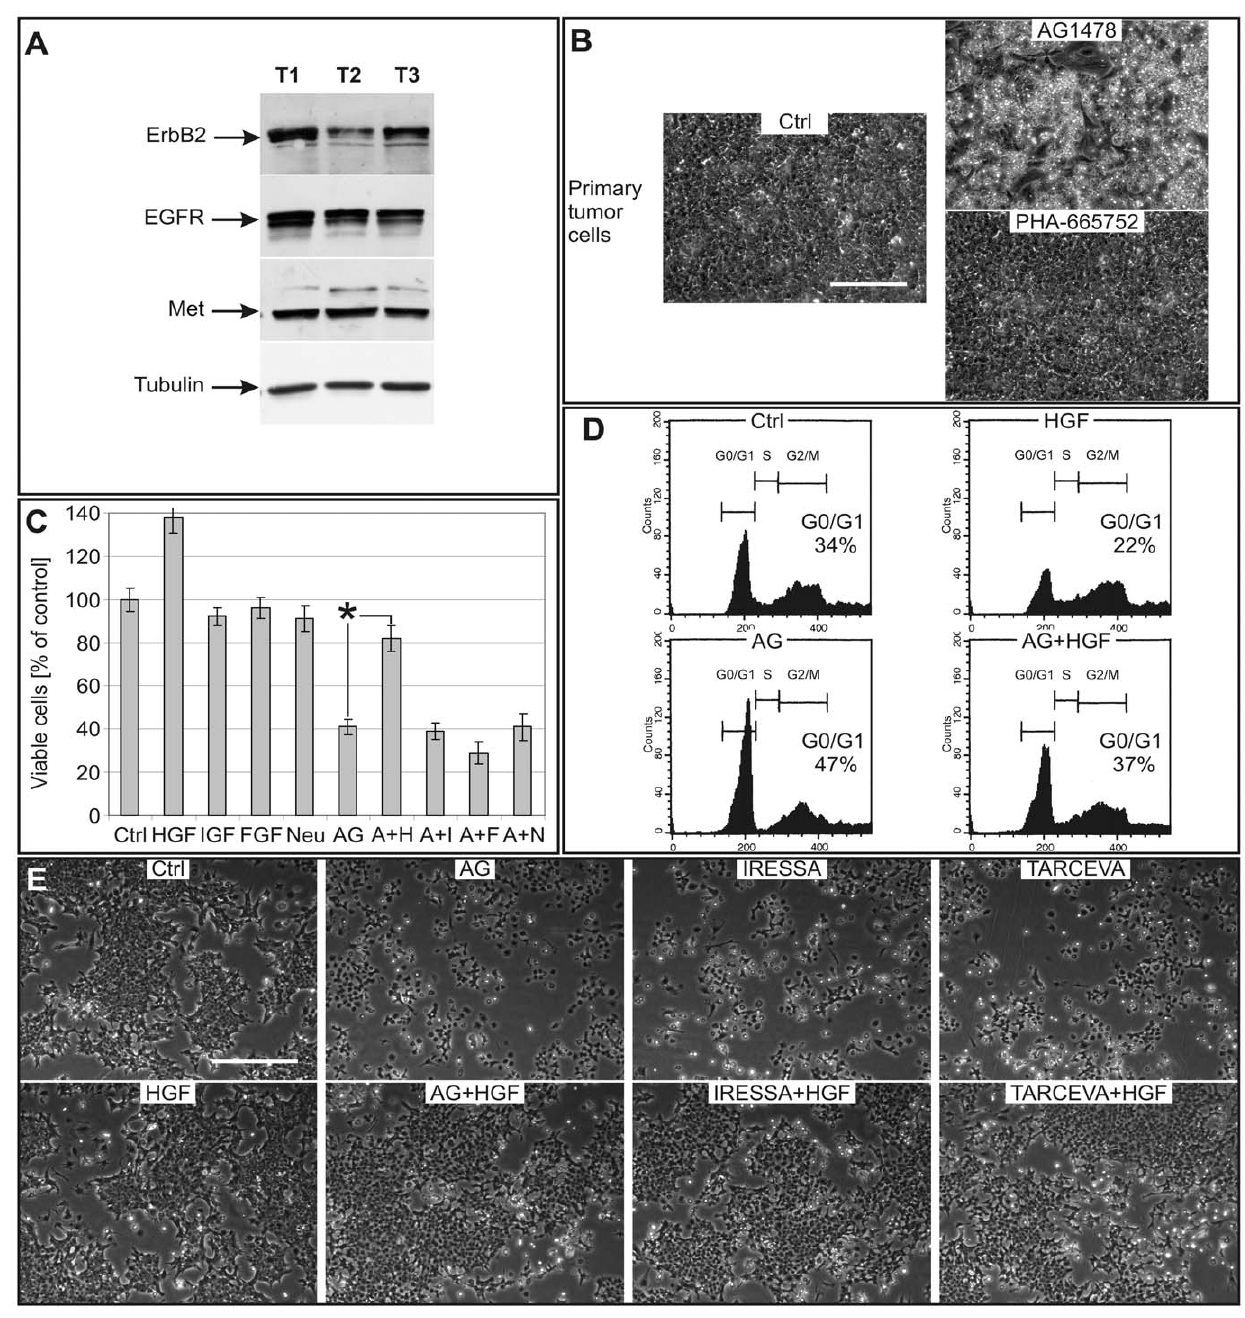
Figure 4. HGF is a survival factor of EGFR inhibited ErbB2 mammary tumor cells. A. Western-blot analysis of ErbB2, EGFR and Met expression in mammary tumors obtained from three separate transgenic ErbB2 mutated mice (see materials and methods). Tubulin was used as an internal loading control. B. Phase contrast images of primary cells from ErbB2 mammary tumors (bar =500 m m). Cells were grown in proliferation medium and either left untreated (Ctrl) or treated with AG1478 (250 nM) or PHA-665752 (250 nM) for 96 h. C. Viable cell count by trypan-blue exclusion staining at 48 h, of immortalized ErbB2 tumor cells treated with the indicated factors (HGF 10 ng/ml (H), IGF-I 100 ng/ml (I), b-FGF 20 ng/ml (F), Neuregulin 20 ng/ml (N); AG1478 250 nM (A)). Untreated control (Ctrl) was set to 100%. Columns, mean (n=6); bars, S.E.M. *P , 0.05. D. Cell cycle distribution examined by propidium iodide staining and FACS analysis of ErbB2 mammary tumor cells cultivated in growth medium and treated with the indicated factors for 16 h (HGF 10 ng/ml, AG1478 250 nM). E. Immortalized ErbB2 tumor cells cultivated in their respective growth medium for 48 h with the indicated factors (HGF 10 ng/ml; AG1478 250 nM; IRESSA 1 m M; TARCEVA 1 m M). Bar =500 m m. doi:10.1371/journal.pone.0044982.g004 emphasizing the fact that molecular events present in non One of the possible mechanisms underlying mammary cell tumorigenic cells could be retained during tumor growth and recovery by HGF treatment following EGFR inactivation was the become the basis for drug resistance. ability of this cytokine to activate both the ERK1/2 and the AKT